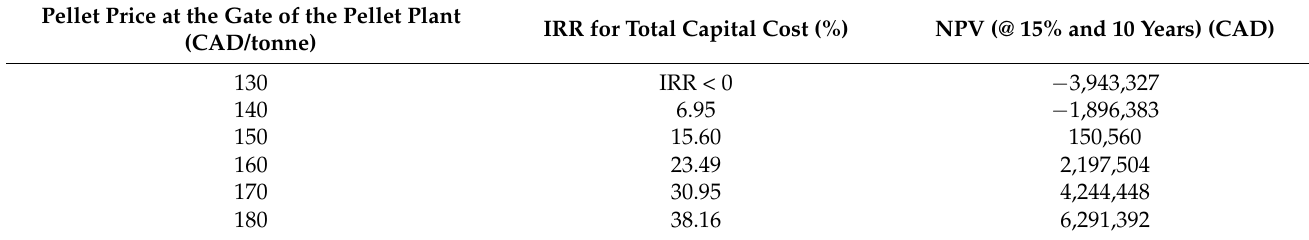
Table 3. IRR and NPV of the ag-pellet plants for different pellet